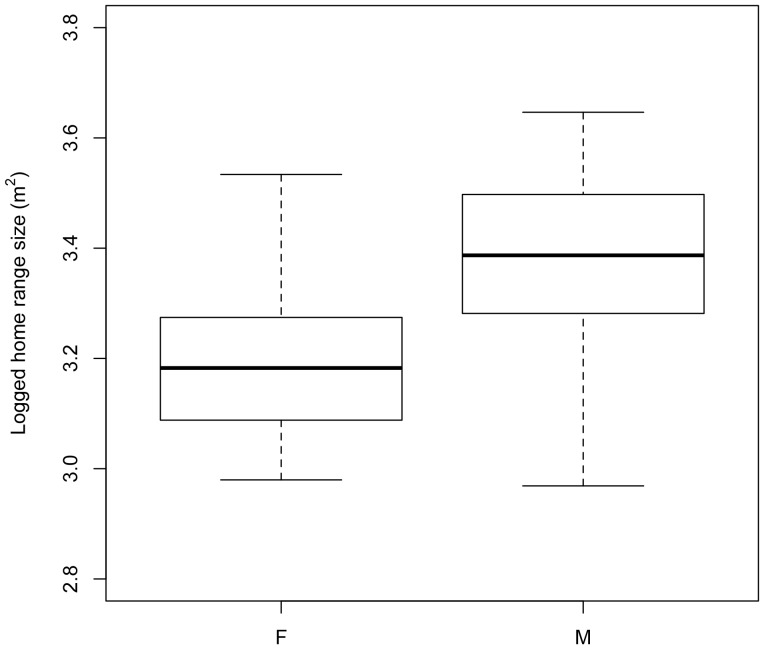
Home range size variations between sexes.Box and whisker plot showing the means, quartile ranges and medians of logged home range size (m2) for both females (F) and males (M). The box edges show the 25th and 75th percentile and the whiskers at the 10th and 90th percentile.